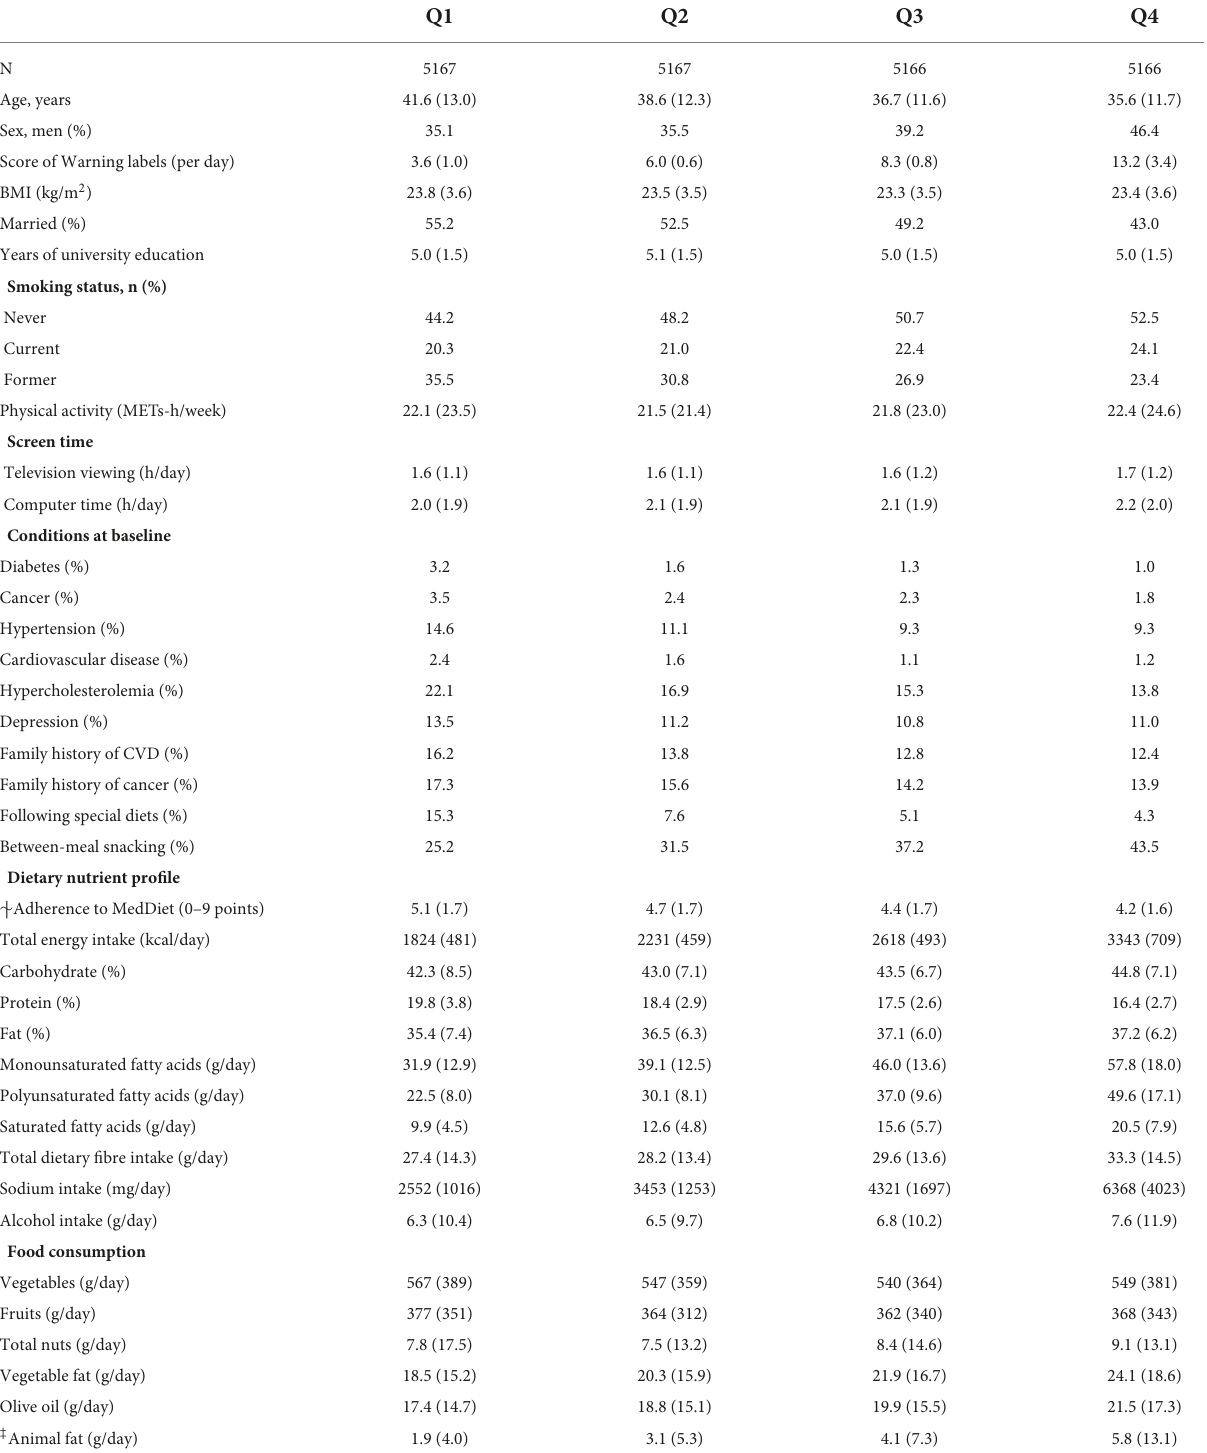
TABLE 1 Baseline characteristics of participants according to quartiles of the score calculated for Chilean warning labels: the SUN (Seguimiento Universidad de Navarra) cohort.